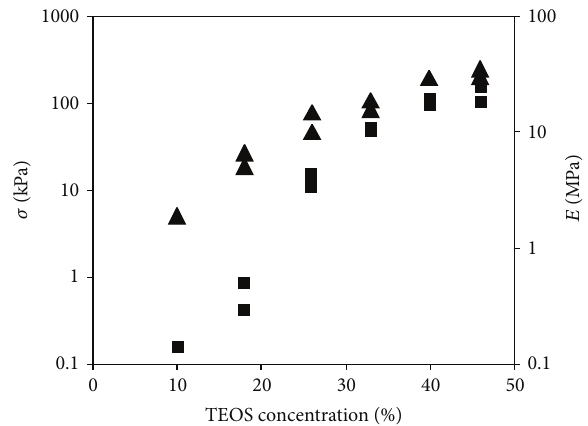
Figure 3: Control of the aerogel elastic modulus ( ◼ ) and mechanical strength ( 󳵳 ) by the TEOS